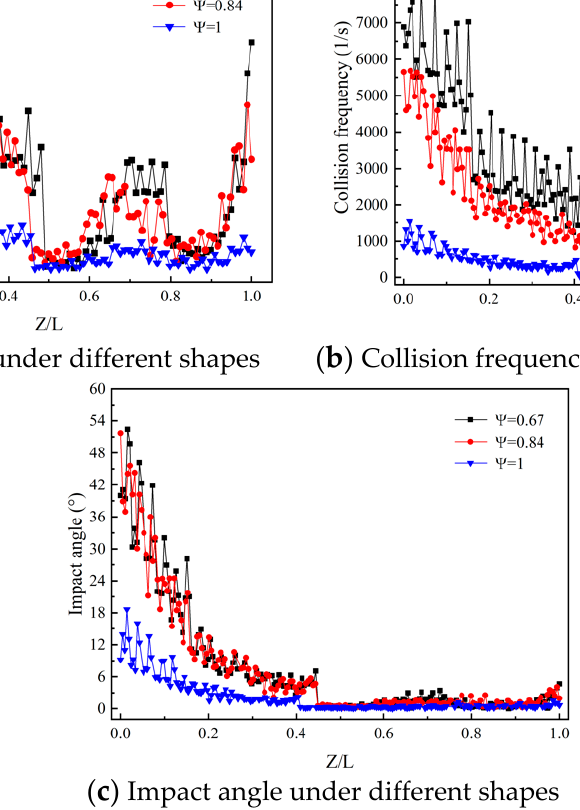
Figure 18. Distributions of erosion rate, collision frequency, and impact angle along the pressure side of the blade with particles of different shapes. ( a ) Erosion rate under different shapes; ( b ) Collision frequency under different shapes; ( c ) Impact angle under different shapes.